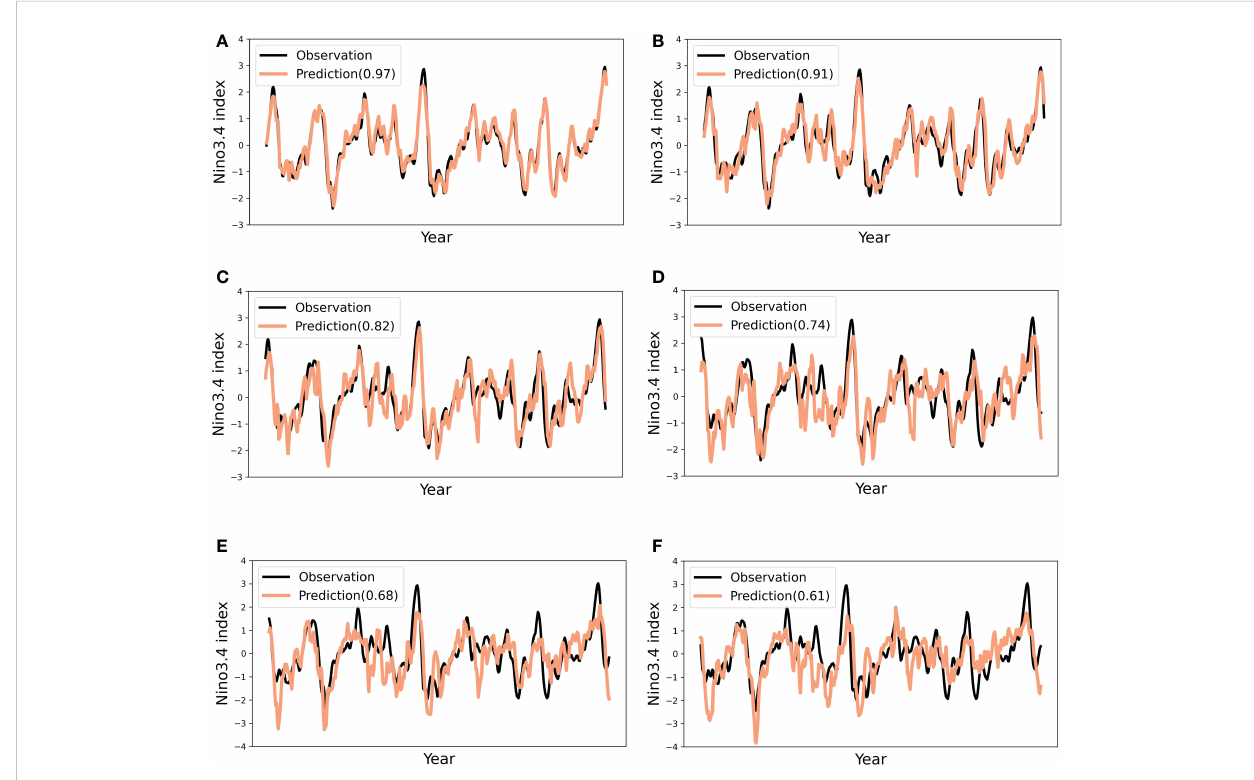
FIGURE 8 The Niño3.4 index of STTN model predictions and observations from 1984 to 2007 with (A) 1, (B) 3, (C) 6, (D) 9, (E) 12, and (F) 15 of lead